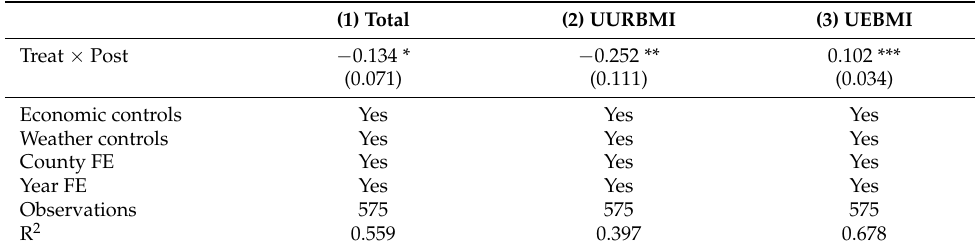
Table 5. Robustness checks: exclude other samples in